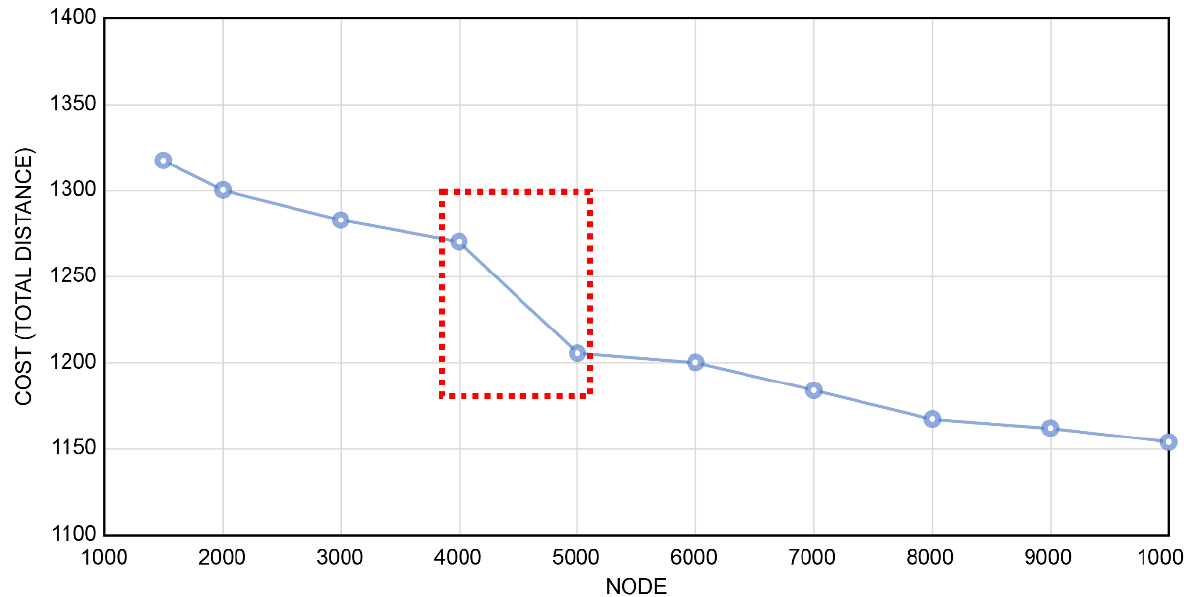
Figure 17. Comparison of the cost based on the number of nodes.